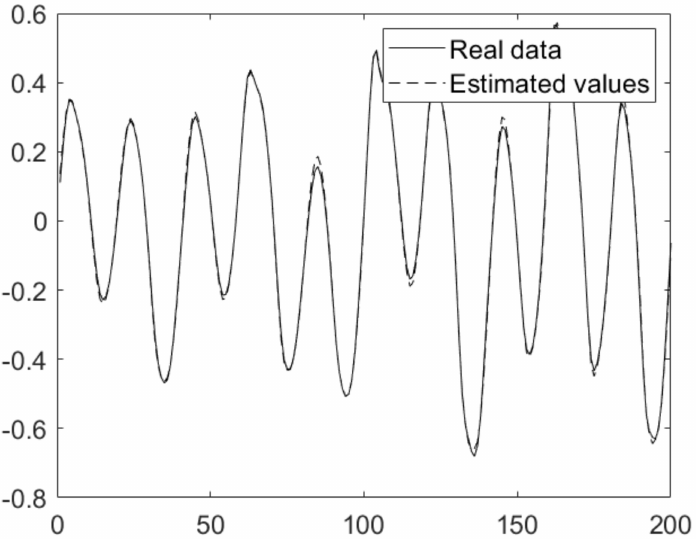
Figure 4. Performance of the proposed prediction method for the time-varying nonlinear system dataset (test